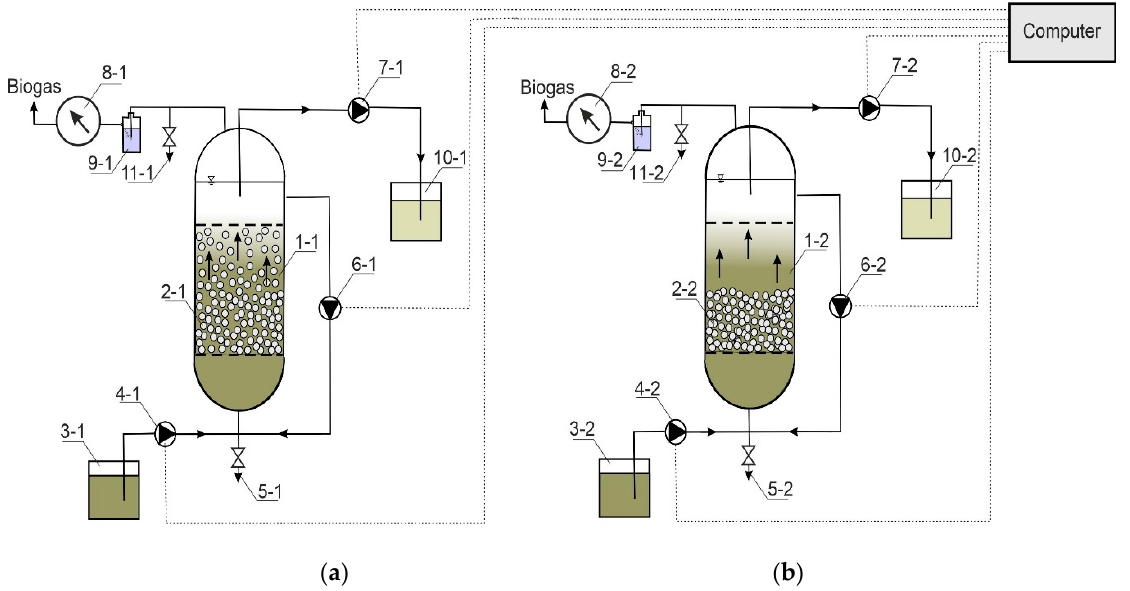
Figure 1. Schematic of a laboratory plant. ( A ) — AFB: 1-1 — reactor vessel; 2-1 — carrier; 3-1 — substrate (CW); 4-1 — feeding pump; 5-1 — sampler; 6-1 — recirculation pump; 7-1 — effluent pump; 8-1 — biogas counter; 9-1 — water seal; 10-1 — effluent; 11-1 — biogas sampler. ( B ) — anaerobic biofilter (AF): 1-2 — reactor vessel; 2-2 — carrier; 3-2 — substrate (CW); 4-2 — feeding pump; 5-2 — sampler; 6-2 — recirculation pump; 7-2 — effluent pump; 8-2 — biogas counter; 9-2 — water seal; 10-2 — effluent; 11-2 — biogas sampler. Table 1. AF and AFB operating